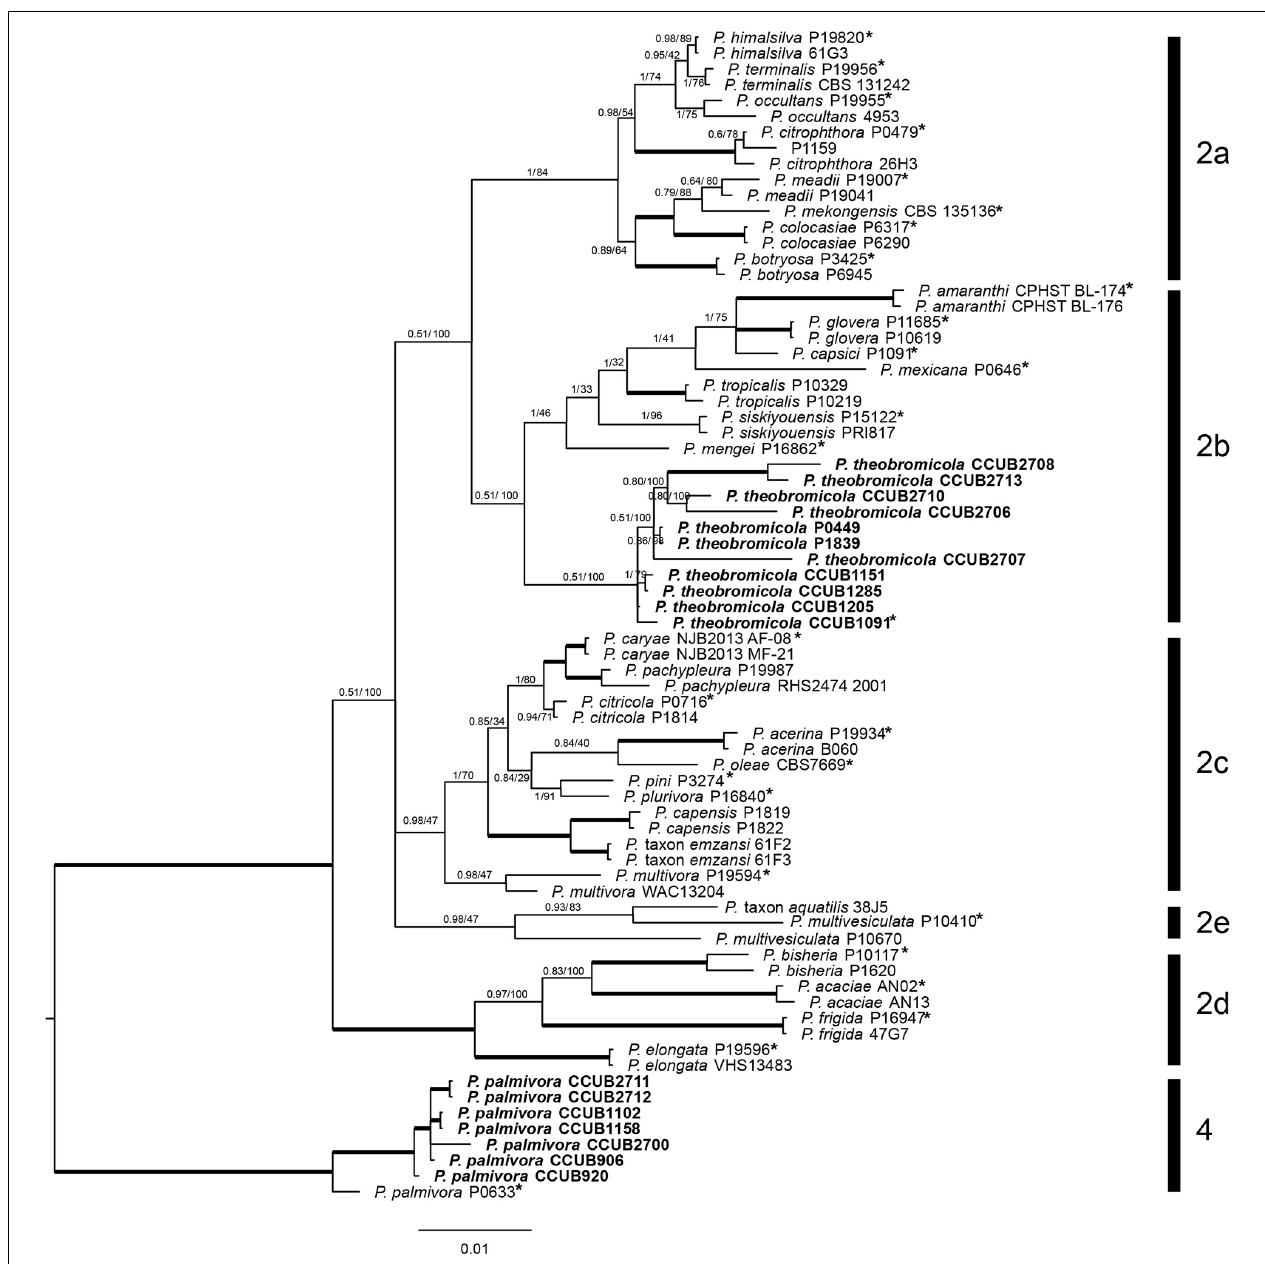
FIGURE 1 | Bayesian phylogenetic tree based on concatenate sequences ( BTUB , COXI , COXII , EF1 α , ITS , and HSP90 ) of Phytophthora clade 2. Bayesian posterior probabilities and Maximum Likelihood bootstrap support values are indicated at the nodes, and the scale bar represents the number of expected changes per site. Thickened lines indicate a posterior probability = 1.00. Ex-type isolates or reference specimens are indicated with an asterisk, and the isolates reported here are highlighted in bold. The reference specimen P0633 of Phytophthora palmivora was used as